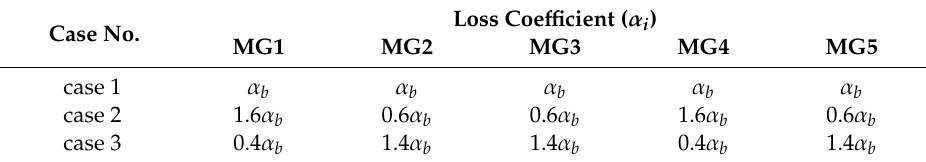
Table 5. Three analysis cases with different loss coefficient values.